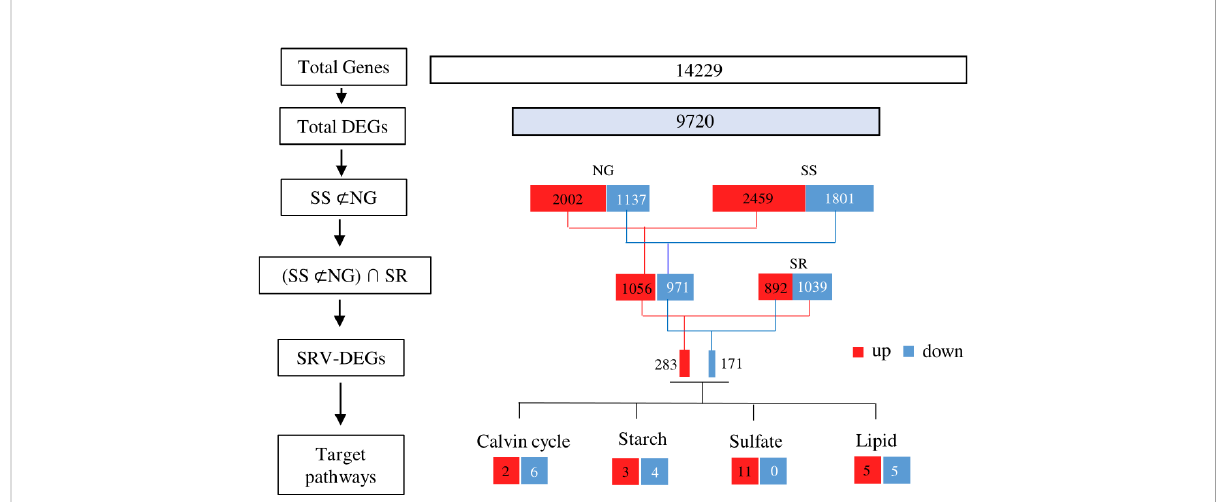
FIGURE 5 A fl ow diagram for RNA-seq data analysis. Left side: the set of genes obtained in each step of the analysis; right side: the number of genes in each set and their expression patterns. NG, normal growth; SS, sulfur starvation; SR,